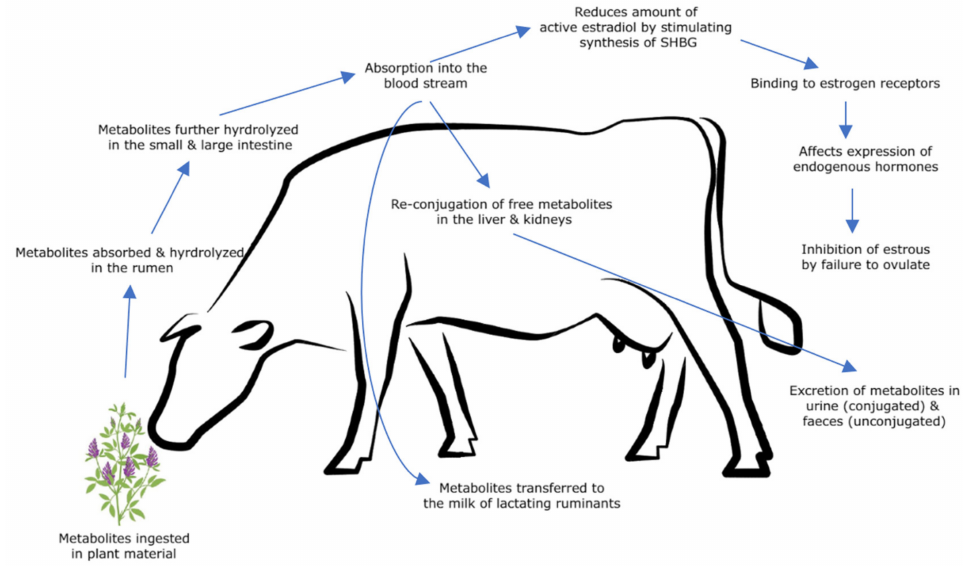
Figure 4. Metabolism of isoflavones and coumestans in grazing